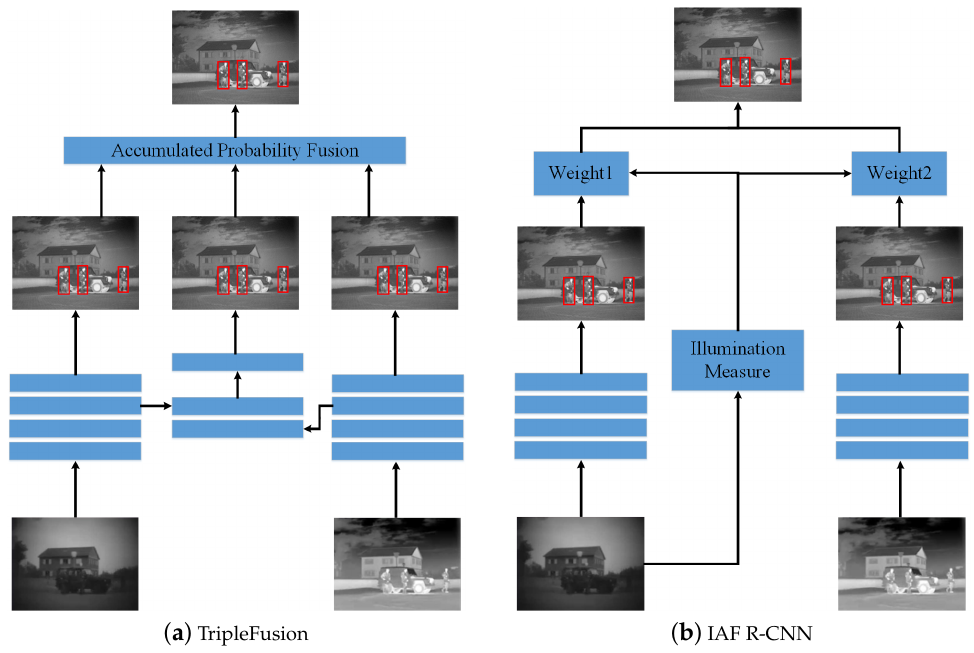
Figure 8. ( a , b ) The pipelines for TripleFusion and IAF